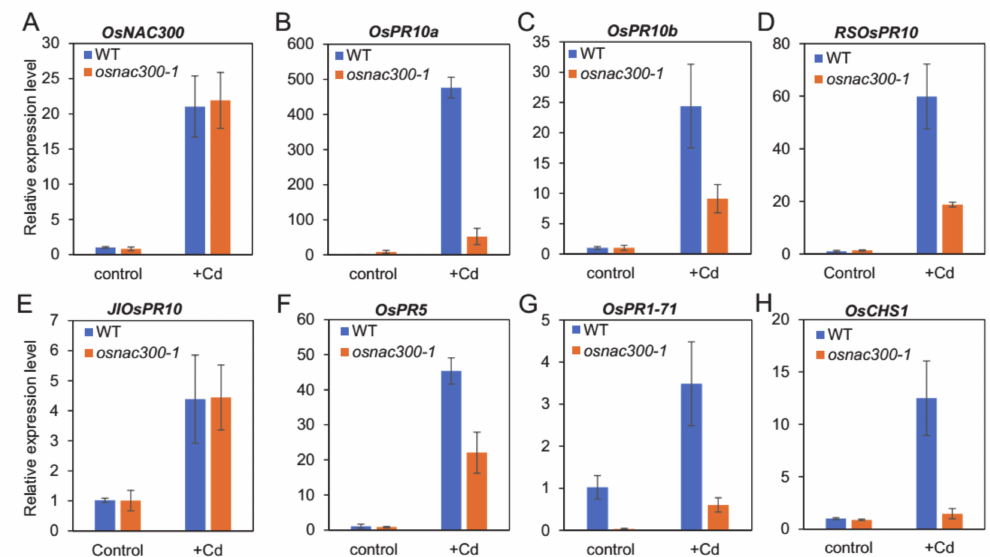
Figure 6. RT-qPCR analysis of potential downstream genes of OsNAC300 under Cd stress. The expression level of OsNAC300 ( A ), OsPR10a ( B ), OsPR10b ( C ), RSOsPR10 ( D ), JIOsPR10 ( E ), OsPR1-71 ( F ), OsPR5 ( G ), and OsCHS1 ( H ) in 2-week-old wild-type and osnac300-1 seedlings treated without or with 100 µ M CdCl 2 for 12 h assayed by RT-qPCR. The relative expression level was obtained by normalization to the expression level in the WT without Cd treatment. Actin was used as the internal standard. Data represent the mean ± SD ( n = 4).